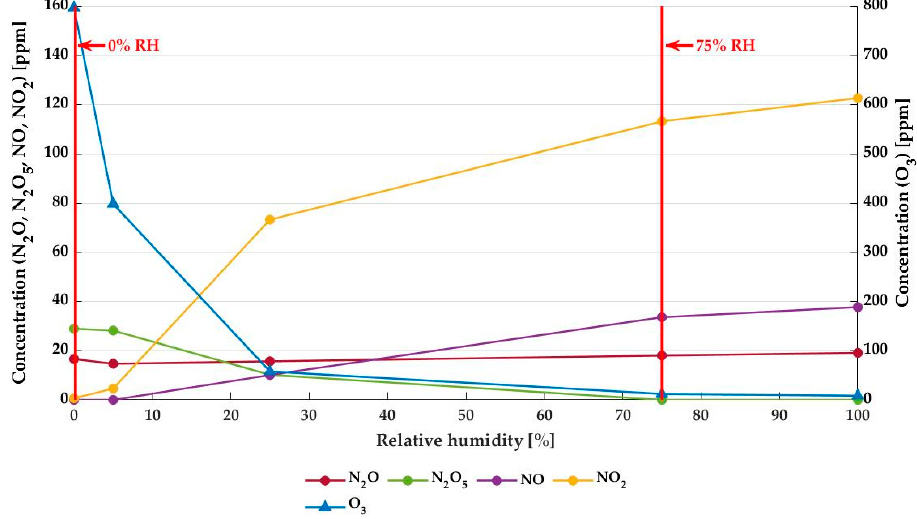
Figure 2. Characterization of NTP by FTIR in the first 50 s of plasma generation as a function of relative humidity of the input air. The left axis shows the concentration of N 2 O, N 2 O 5 , NO, and NO 2 (circles); on the right axis, the concentration of ozone (O 3 ) in the plasma is projected (triangles).